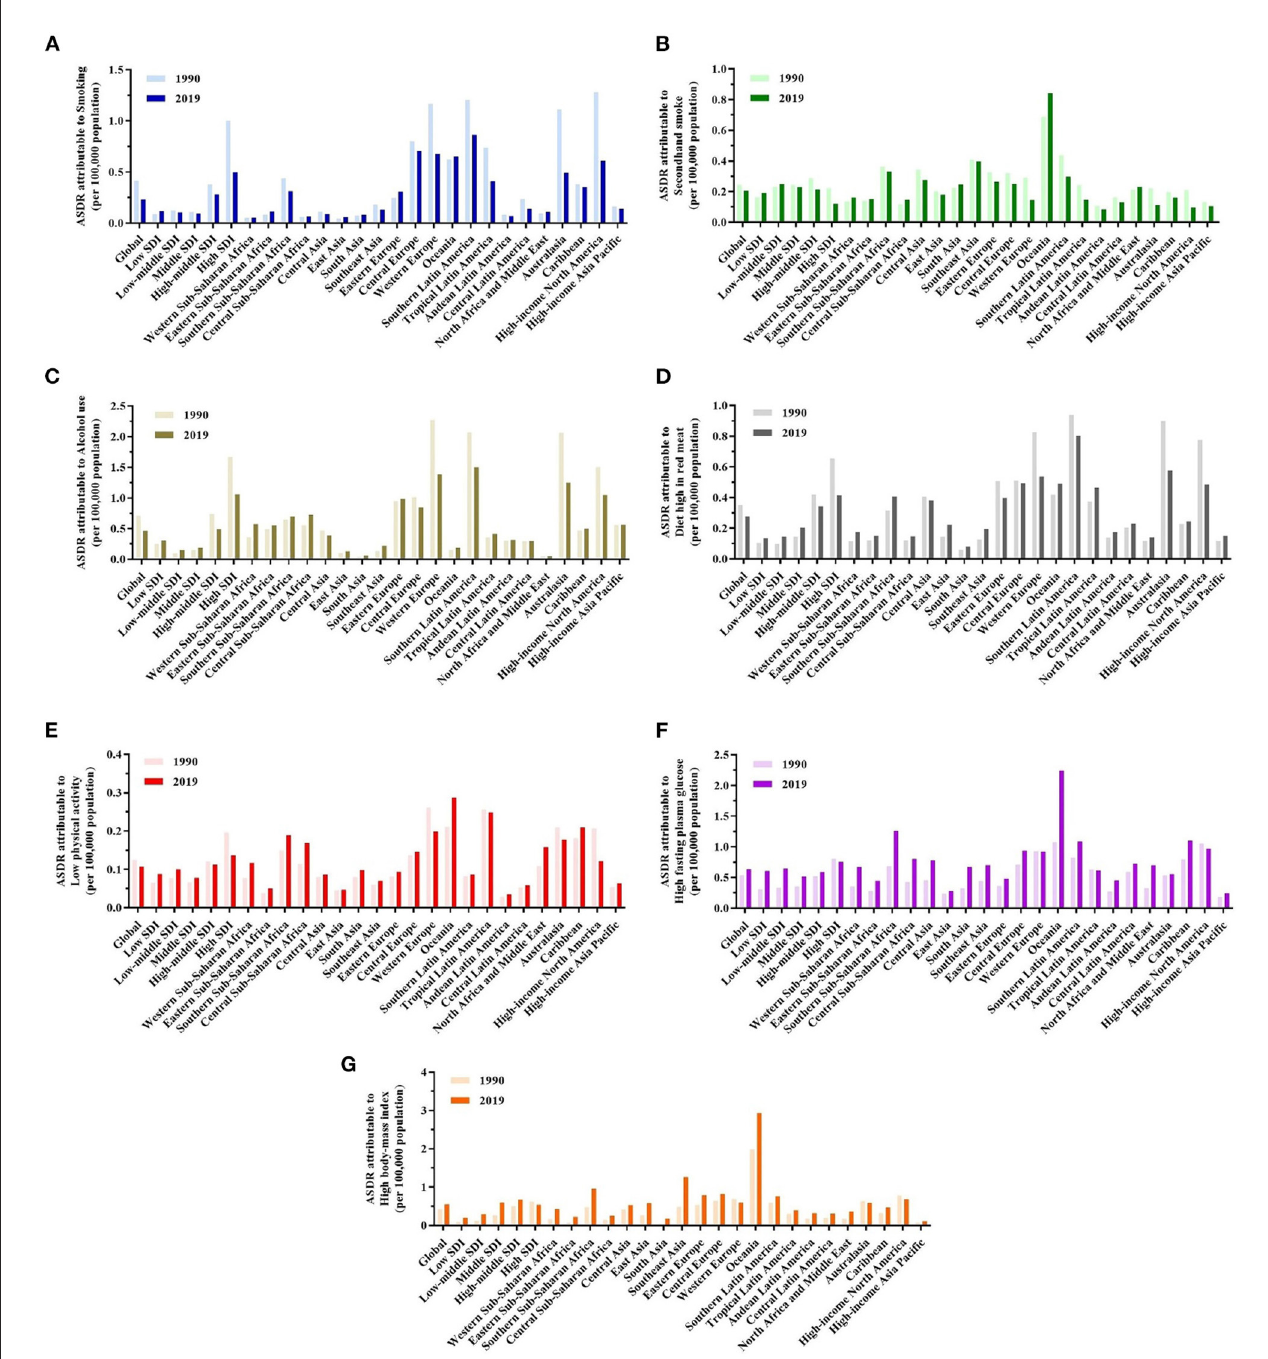
FIGURE4 A predominant contribution of risk factors to breast cancer-related deaths in different regions and territories with a low to high SDI and in 21 GBD regions in 1990 and 2019. (A–G) ASDRs attributable to smoking, secondhand smoke, alcohol consumption, a diet high in red meat, low physical activity, high fasting plasma glucose (FPG), and high body mass index